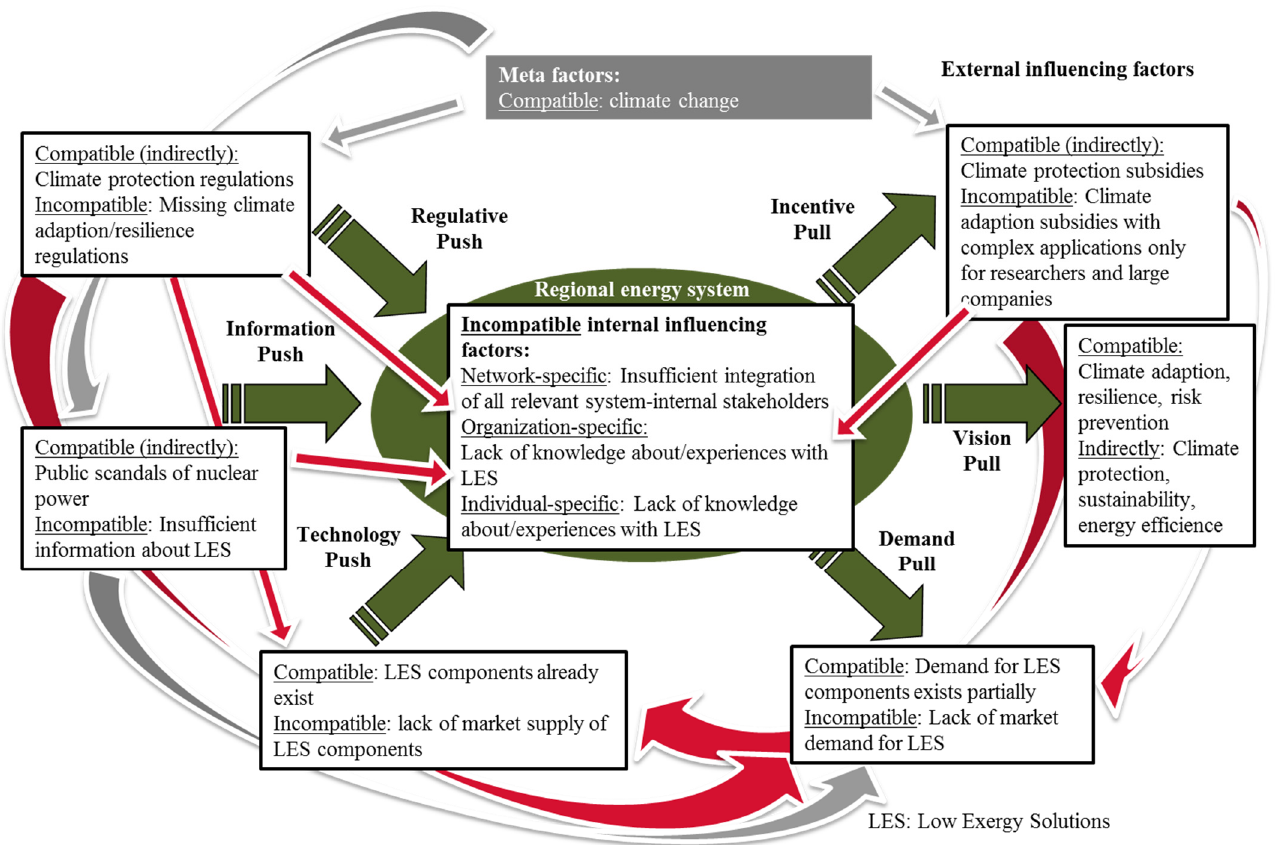
Figure 7. Filled turtles model of the Northwestern Gemany energy system showing compatible and incompatible directional impetuses in the context of the guiding design principle of “low-exergy solutions